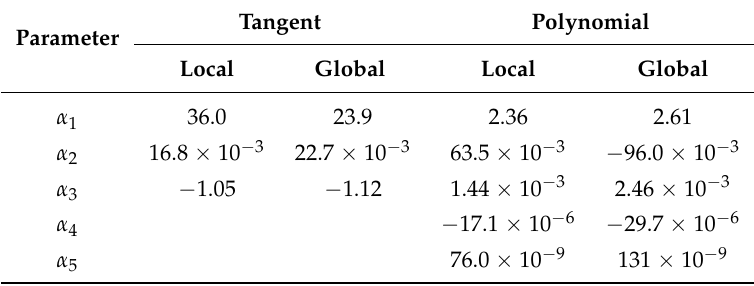
Table 1. Curve fit parameters from MCP per-sensor VWC to water depth for each of the models. The local columns are the parameters extracted from the per-sensor data, and the global columns are the parameters optimized over the whole